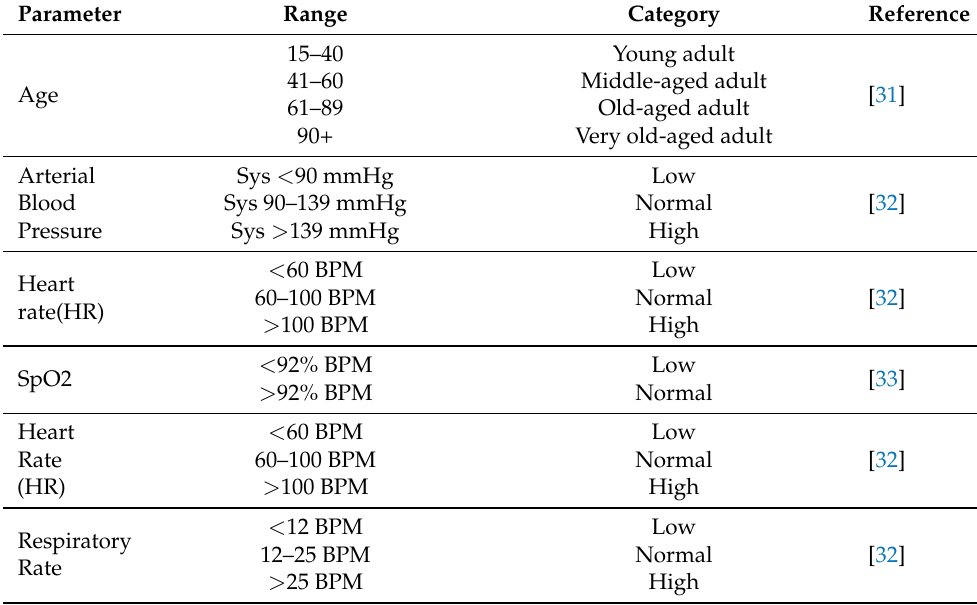
Table 1. Medical parameters, set of category terms, and their ranges.